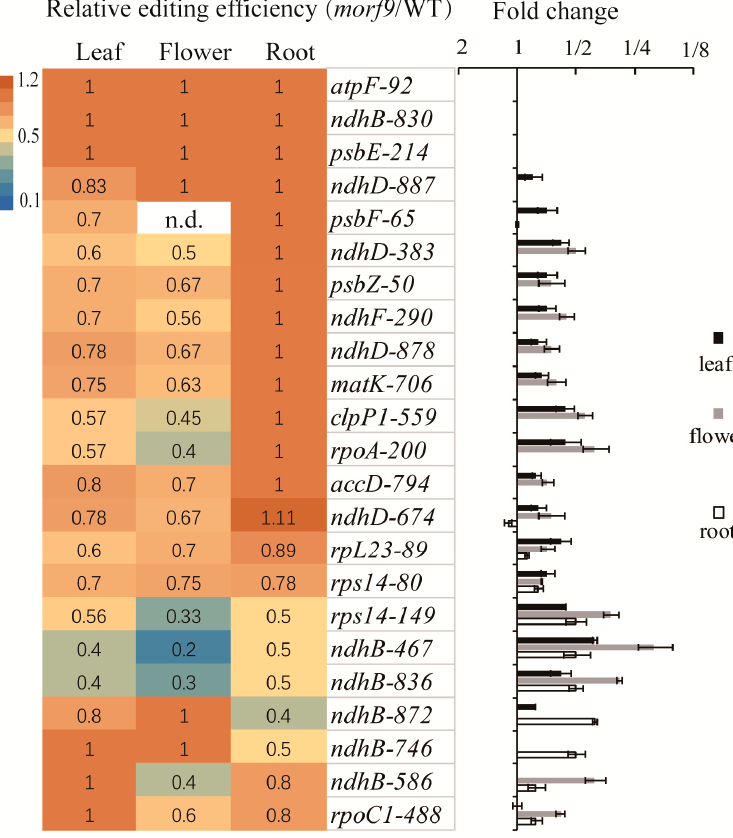
Figure 6. Summary of relative plastid RNA editing efficiency in the indicated organs in morf9 plants as compared to WT plants. The left panel shows the average ratio of morf9 mutant’s to WT line’s editing efficiency from three replicates. The right panel plots the fold change relative to the WT, showing standard errors of the replicates. Full dataset are provided in Supplemental Table S2.